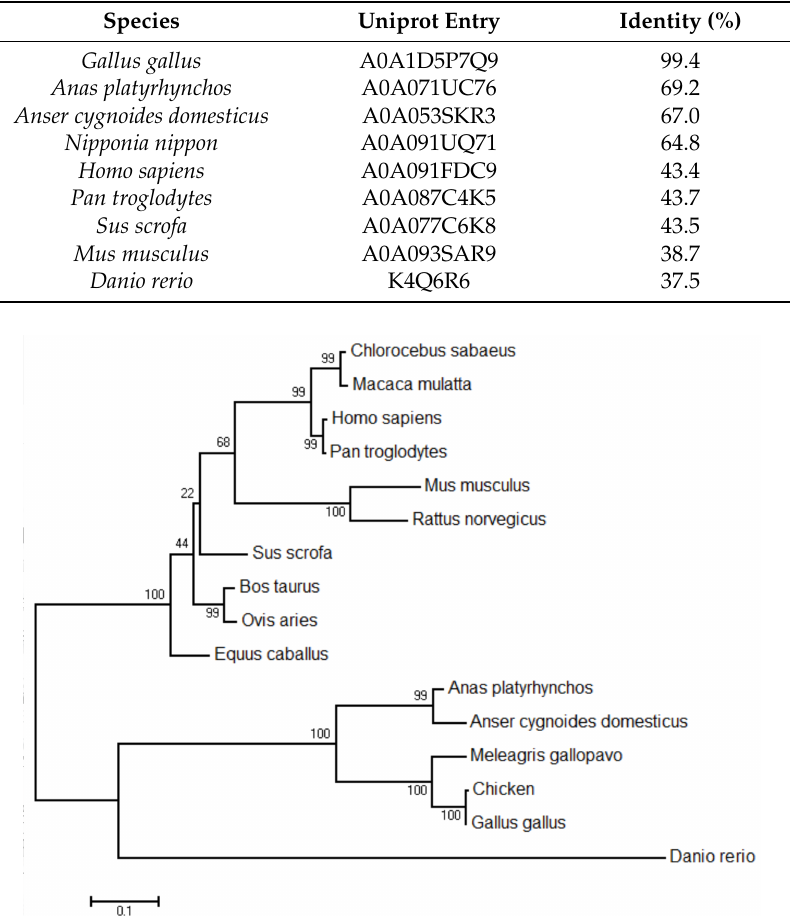
Figure 3. Phylogenetic analysis of chicken STING . The scale bar is